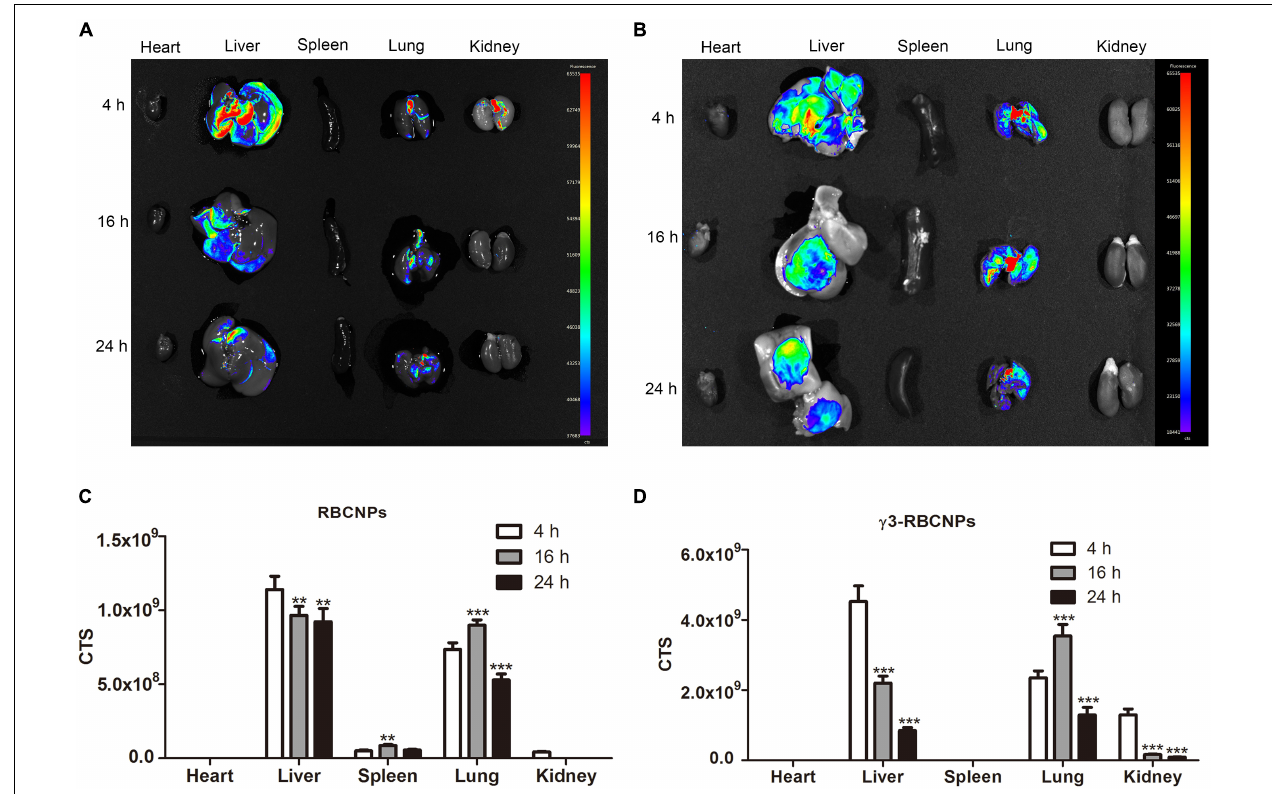
FIGURE 4 | The targeting capacity of γ 3-RBCNPs in vivo . Drug distribution in major organs of mice with acute pulmonary infection treated with RBCNPs (A) and γ 3-RBCNPs (B) at 4, 16, and 24 h. Quantification of the fluorescence intensity in the main organs of mice in RBCNPs (C) and γ 3-RBCNPs (D) groups. ** P < 0.01 vs. 4 h group. *** P < 0.001 vs. 4 h